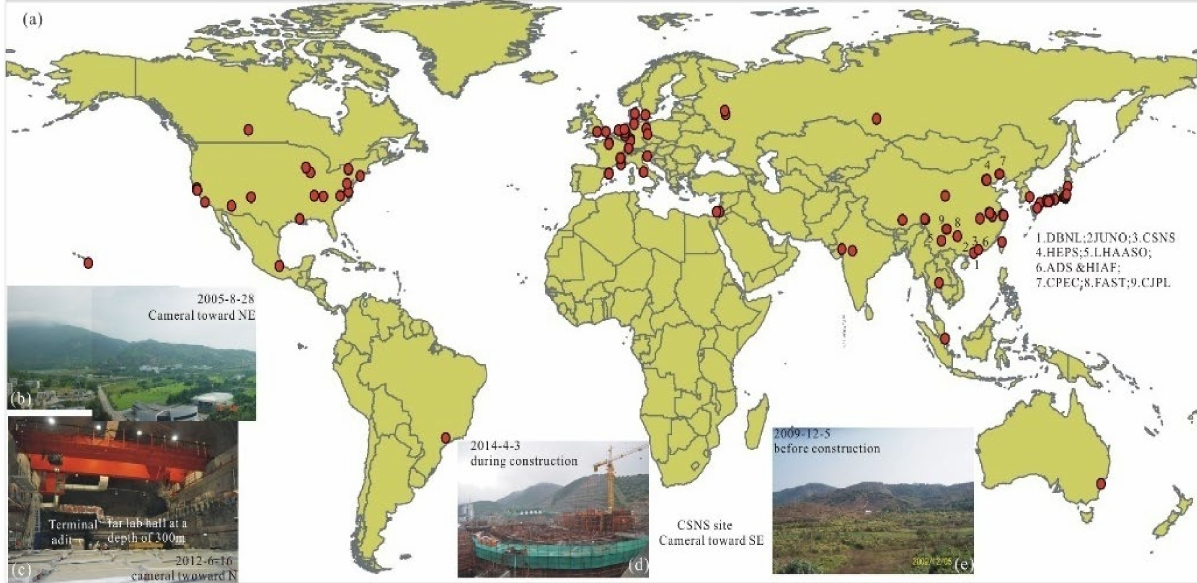
Figure 1. ( a ) Distribution of RIs worldwide (location data from [11]). Some of the Chinese RI locations are labeled with numbers (1–9). The investigated sites DBNL and CSNS are labeled with numbers 1 and 3, respectively. ( b ) The view of the DBNL site environment before construction. ( c ) The view of the far hall in the DBNL site during construction. ( d ) The view of the CSNS site during construction. ( e ) The view of the CSNS site before